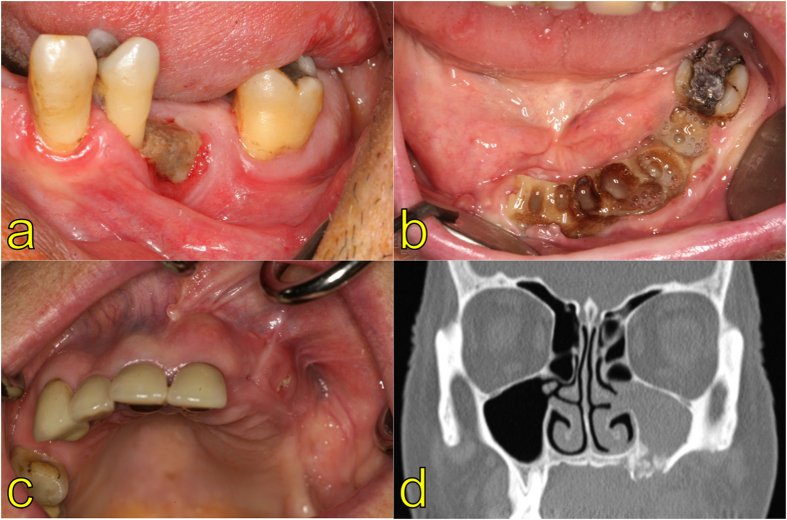
Clinical findings in patients suffering from MRONJ showing necrotic alveolar bone (Stage 1) distal to a premolar tooth (a) or large areas of exposed bone with sings of infection (Stage 2) caused by tooth extractions under bisphosphonate therapy (b). Despite no large portion of necrotic bone in the maxilla (c), Stage 3 is characterized by severe infection leading to maxillary sinusitis in the presented case (d).